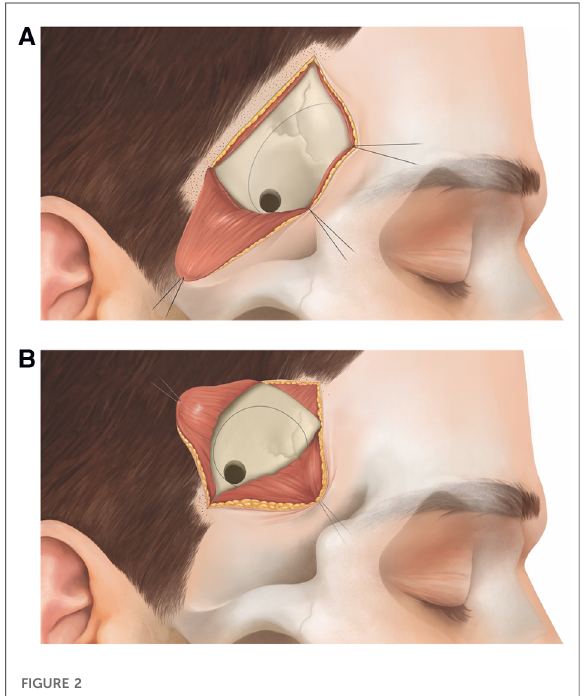
FIGURE 1 Schematic representation of the skin incision and craniotomy for the ( A ) MPT and the ( B ) SKA.